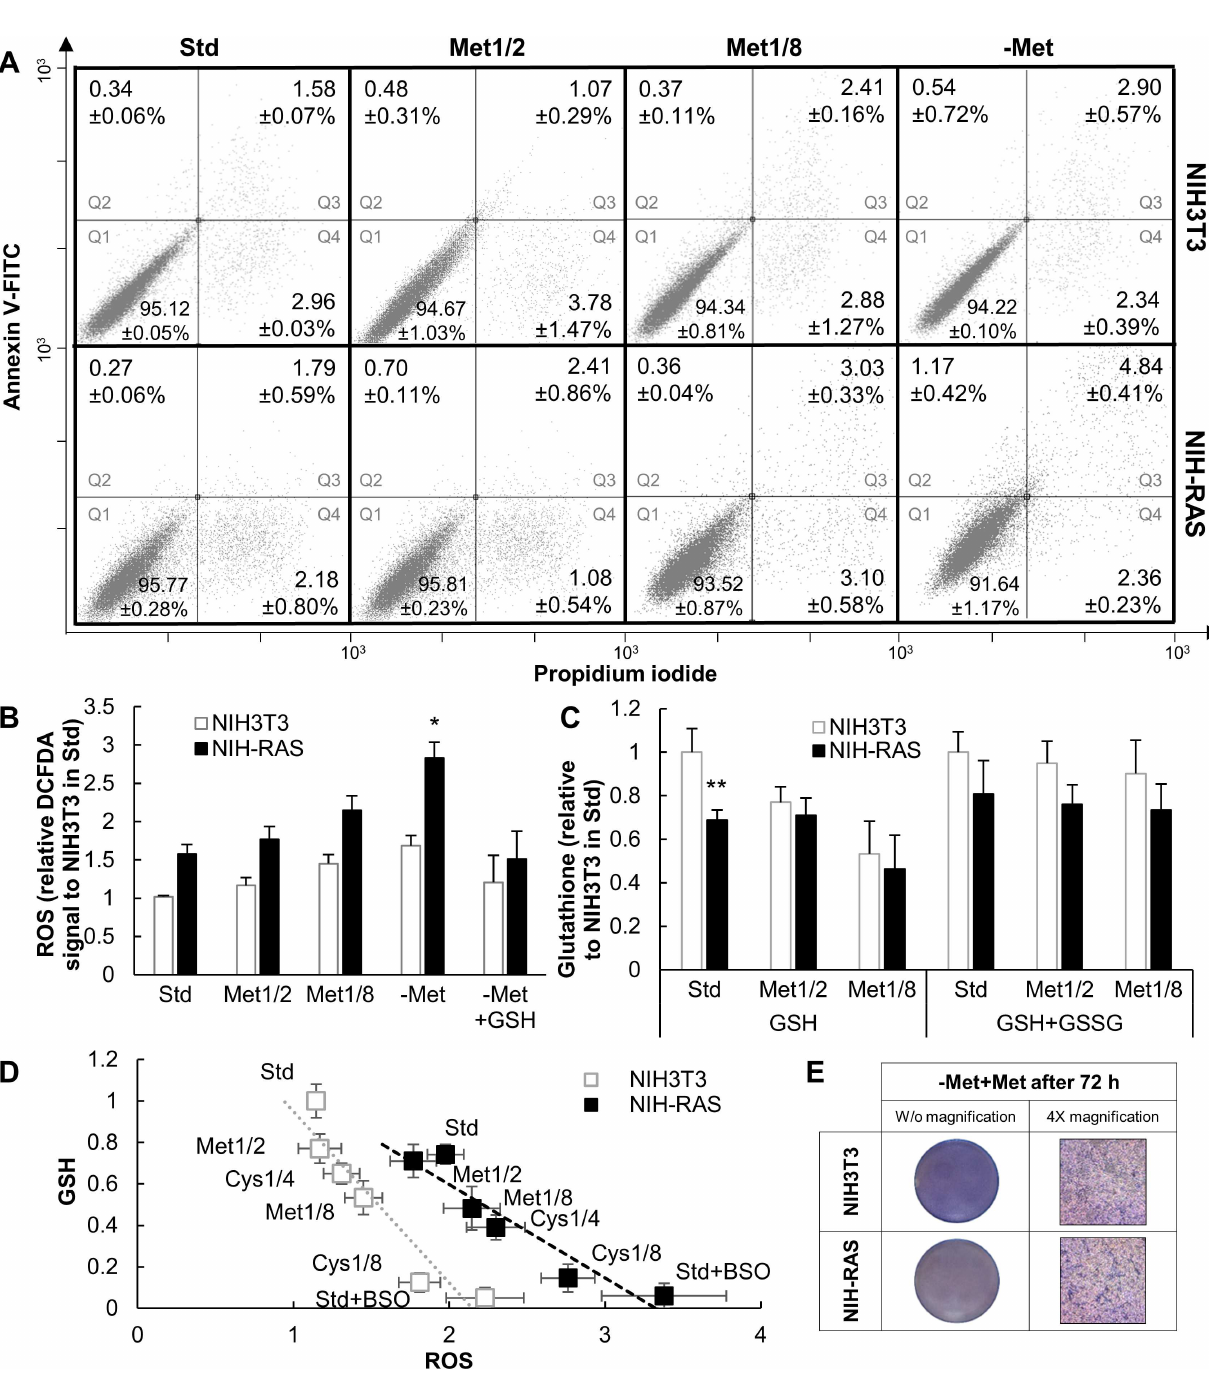
PLOS ONE | DOI:10.1371/journal.pone.0163790 September 29,